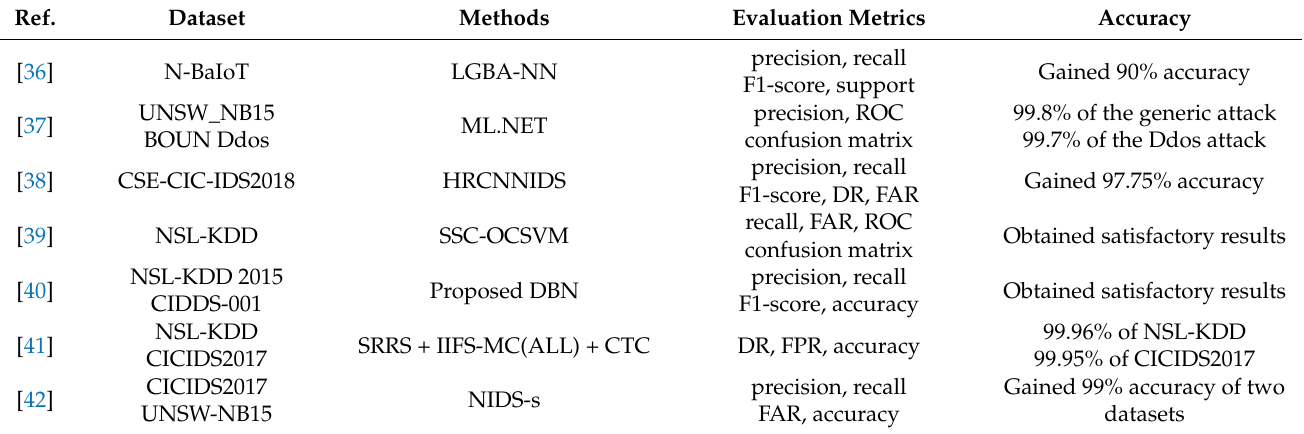
Table 1. A brief description of the recent related works on network intrusion detection, using several optimization, deep, and machine learning